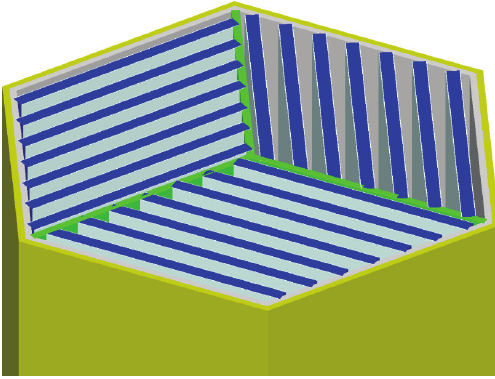
Figure 1: GFR600 fuel assembly. Each assembly contains 21 fuel plates and a central restraining device. All components are made of SiC. Reactivity for di ff erent MA loading-t.d. 88%